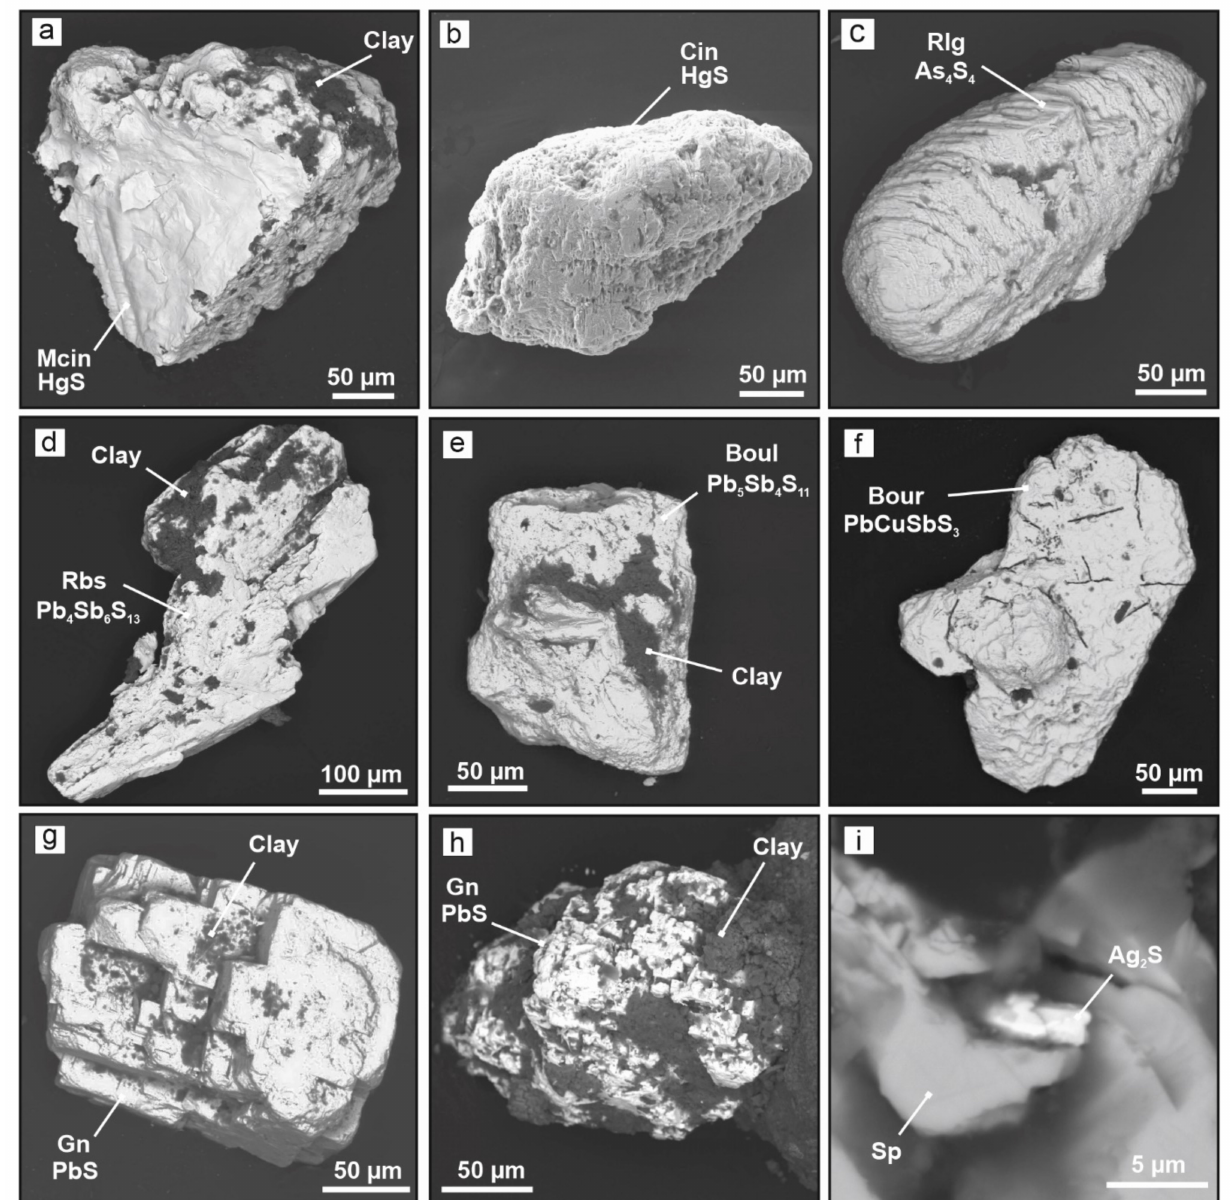
Figure 8. Morphology of host sulfides for Hg, As, Pb, Sb, Cu, and Ag from mud masses extruded by Pugachev ( a – g , i ) and South Sakhalin ( h ) MVs. ( a ) Metacinnabar grain; surface contaminated with clay. ( b ) Rounded fragment of rhombohedral cinnabar crystal. ( c ) Rounded elongated grain of realgar. Angular grains of Pb, Sb, Cu sulfosalts contaminated with clay: ( d ) = robinsonite. ( e ) = boulangerite, ( f ) = bournonite. ( g,h ) Cubic galena crystals with rough growth steps. ( i ) Particles of sil- ver sulfide ( α -Ag 2 S?) on the surface of sphalerite crystal. ( a , c – i ) back-scattered electron (BSE) images, ( b ) secondary electron (SE) image. Boul = boulangerite; Bour = bournonite; Cin = cinnabar; Gn = galena; Mcin = metacinnabar; Rbs = robinsonite; Rlg = realgar; Sp =